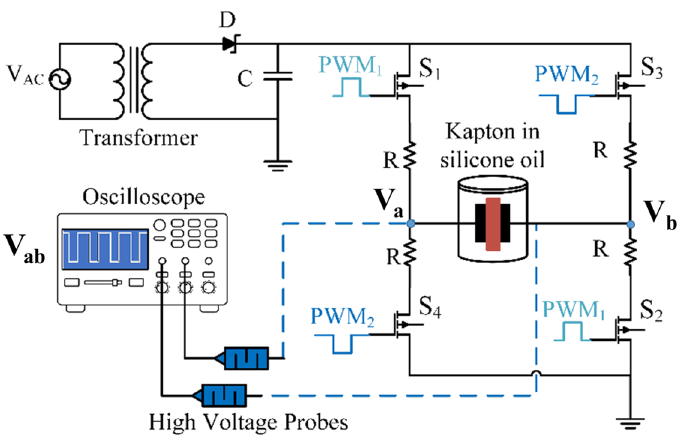
Figure 19. Schematic of 2 level medium-voltage inverter setup.